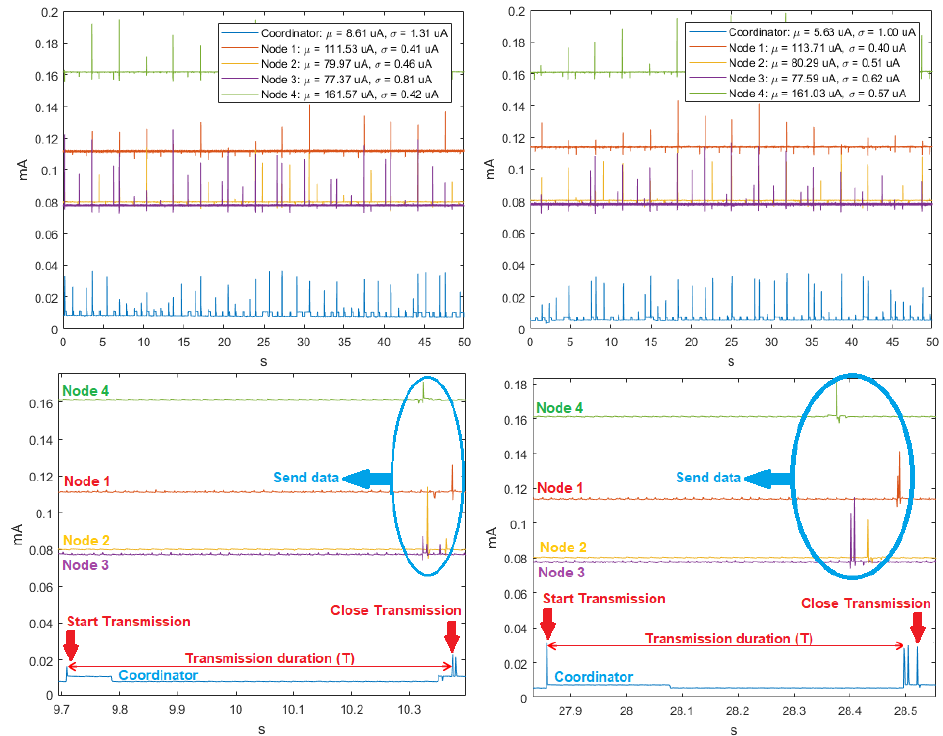
Figure 2. Time signals for DigiMesh network in two example realizations: ( Left ) at 19,200 bauds; ( Right ) at 57,600 bauds; ( Top ) complete time signals; and ( Bottom ) signal sections with closer